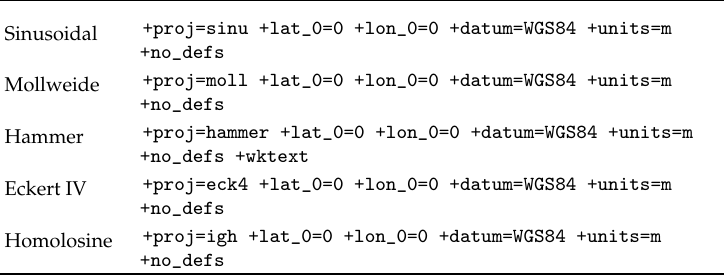
Table 2. PROJ strings used in this